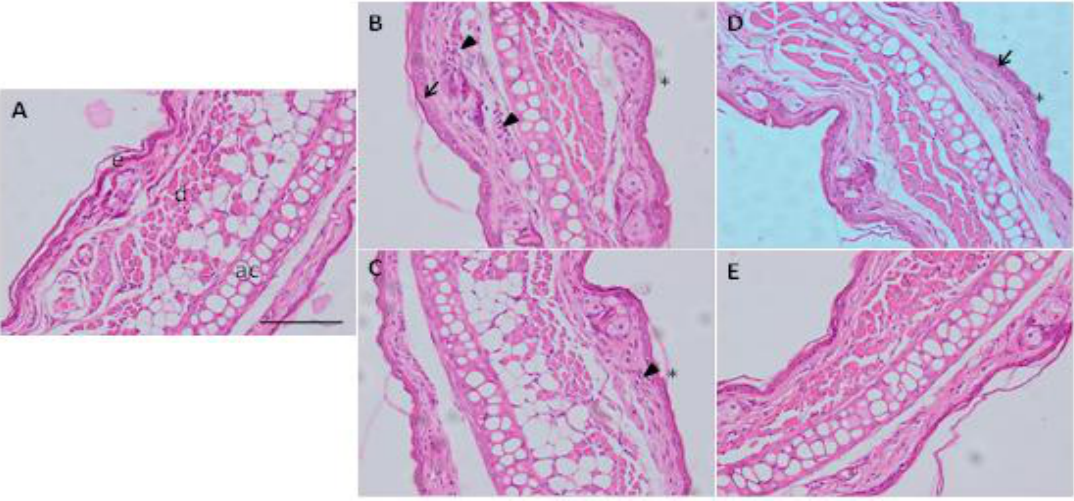
Figure 9. Representative micrographs of mice ear (x200 magnification). ( A ) = Non-inflamed ear, ( B ) = Positive control (inflamed ear with arachidonic acid), ( C ) = pranoprofen alone, ( D ) = pranoprofen (0.75 mg/mL) + linoleic acid (5%) (NLCs-F3-L), ( E ) = pranoprofen (0.5 mg/mL) + linoleic acid (5%) (NLCs-F9-L). Scale bar = 100 µM. e = epidermis, d = dermis, ac = auricular cartilage. Arrowheads indicate neutrophilic infiltrates, arrows indicate increased epidermis, and asterisks indicate loss of stratum corneum.